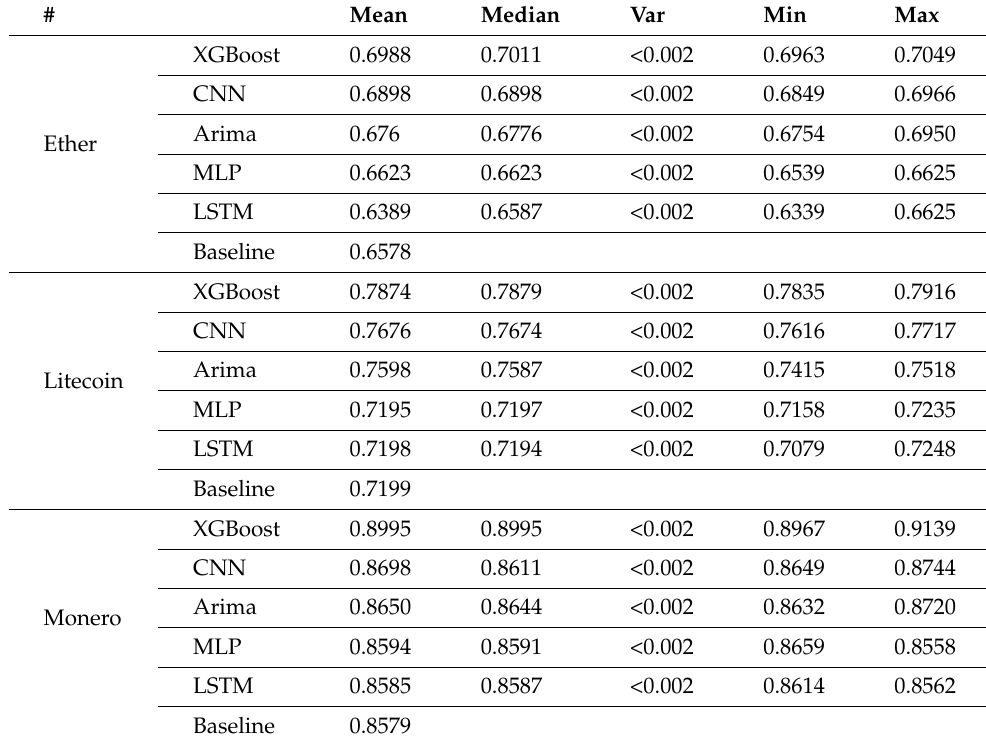
Table 5. Statistic prediction accuracy records of